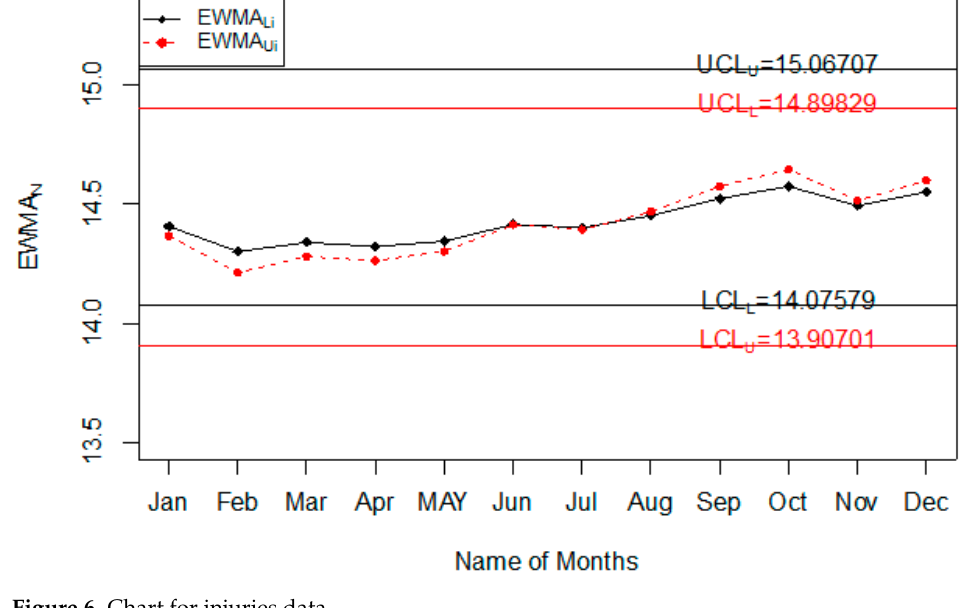
Figure 6. chart for injuries data. Figure 6. Chart for injuries data.